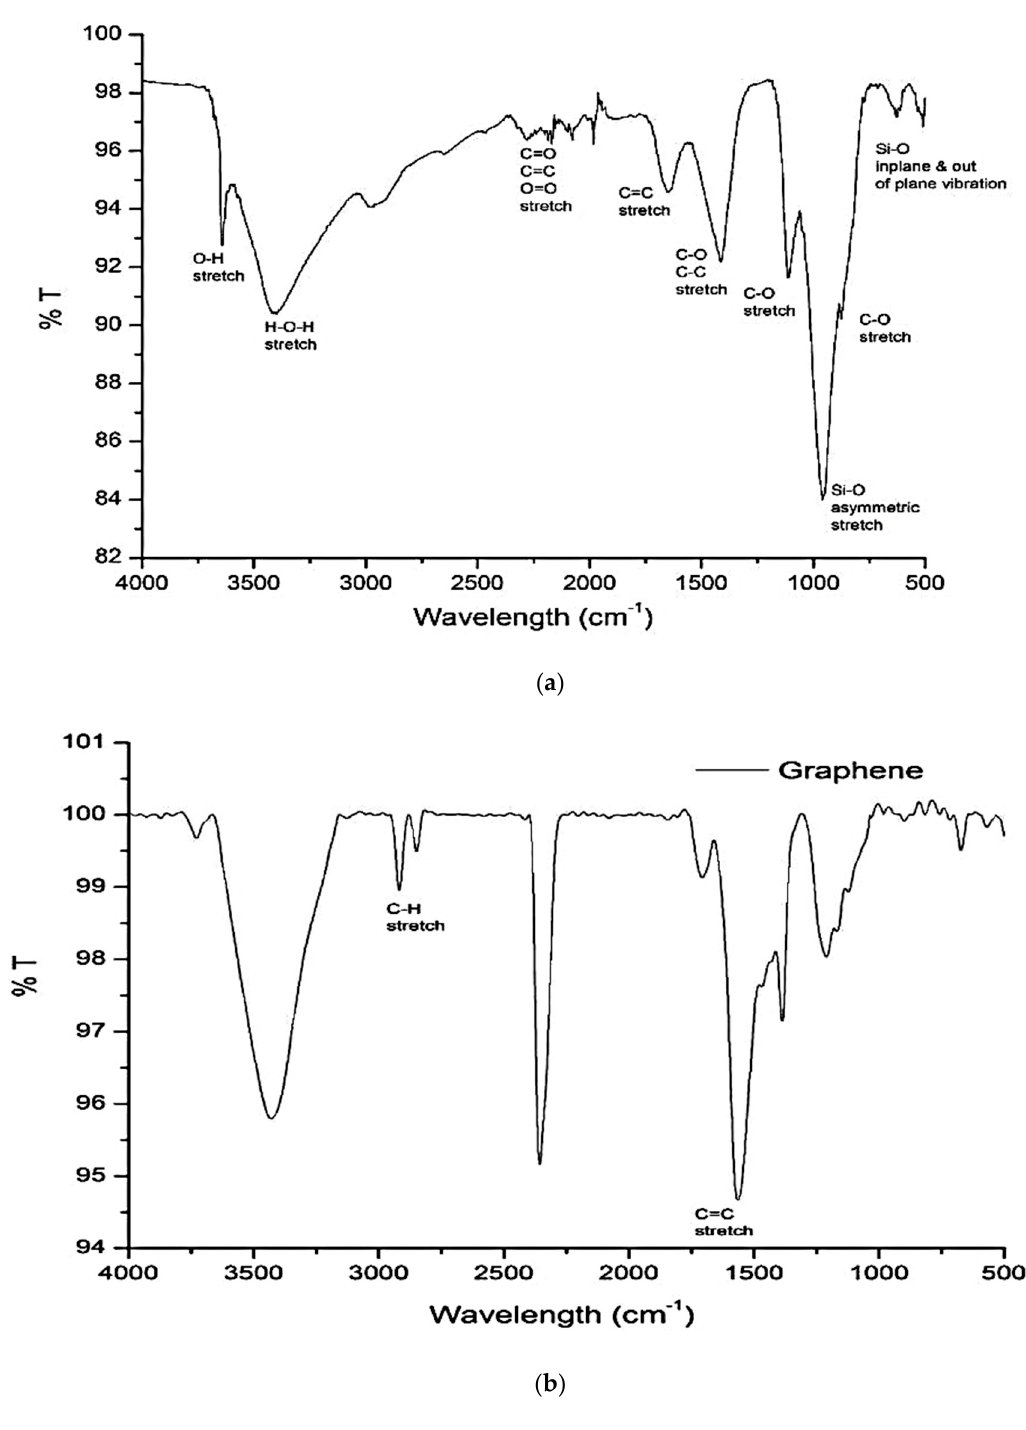
Figure 12. Analysis of FTIR spectra of ( a ) control sample adapted from [48] Elsevier, 2005 and ( b ) graphene adapted from [88], RSC Advances, 2015.